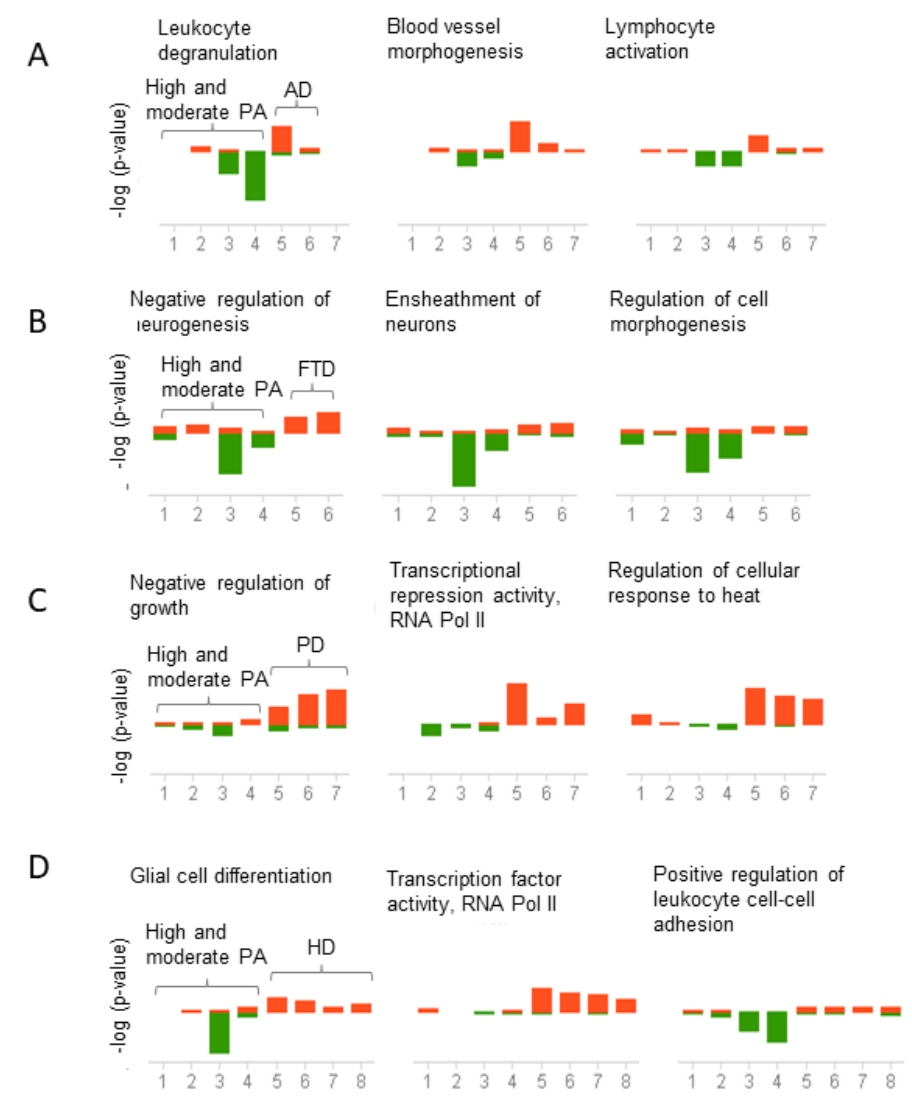
Figure 6. Correlation analysis of pathways shared between physical activity and neurodegenerative diseases. Genes downregulated in physical activity (PA) and upregulated in neurodegenerative diseases were analyzed using the meta-analysis and correlation in BSCE. The analysis was performed for each neurodegenerative disease separately. Gene ontology (GO) association terms were used for functional analysis. GO groups were filtered using a minimum size of 10 genes and a maximum of 500 genes per group. Each correlated biogroup has an associated score matrix. The height of each vertical bar represents the score of the correlation between the queried dataset and the biogroup (GO group). The orange bar above the midline represents the overlap, or enrichment, between the dataset and the upregulated genes in the dataset. Likewise, the green bar below the midline represents the overlap, or enrichment, between the dataset and the downregulated genes in the dataset. The absence of a colored bar means that the correlation is insignificant. The datasets analyzed are represented on the x-axis. High and moderate physical activity datasets (1–4) compared to ( A ) Alzheimer’s disease (AD) datasets (5–7), ( B ) Frontotemporal dementia (FTD) datasets (5–6), ( C ) Parkinson’s disease (PD) datasets (5–7), ( D )Huntington’s disease (HD) datasets (5 = HD grade 1, 6 = HD grade 2, 7 = HD grade 3, 8 = HD grade